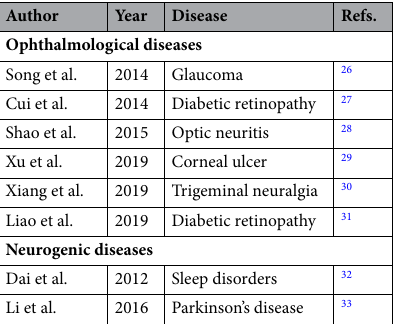
Table 4. Application of ReHo in ophthalmology and other diseases.